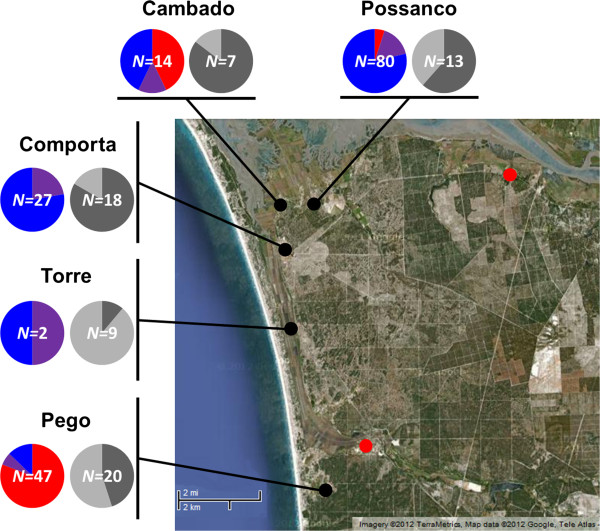
Frequency of the groups defined by STRUCTURE by locality. Black dot: positive sample site for Cx. pipiens s.s. (Cambado, Comporta, Pego, Possanco, Torre); Red dot: negative sample site for Cx. pipiens s.s. (Carvalhal, Monte Novo do Sul). Color graphics: proportion of females; Red: cluster 1 (molestus form); Blue: cluster 2 (pipiens form); Purple: admixed (hybrids). Grey-scale graphics: proportion of mosquito collections; Dark grey: proportion of collection performed in chicken coops; Light grey: proportion of collection performed in other type of shelter.